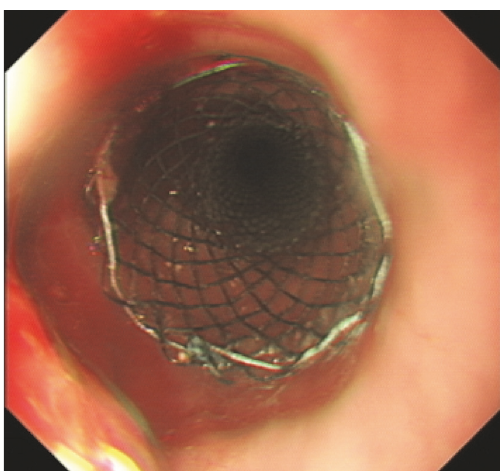
Figure 7: Lower oesophagus